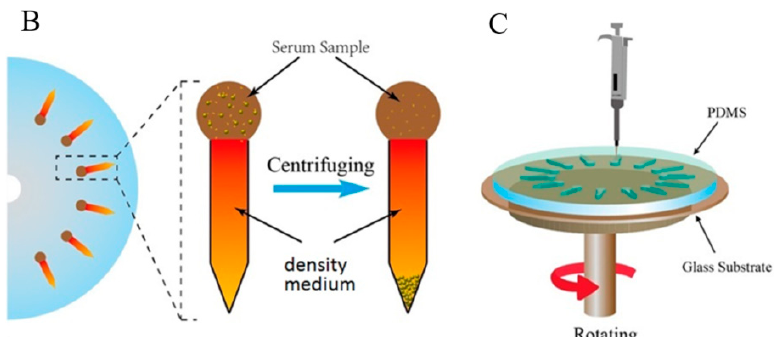
Figure 1. Design of the centrifugal microfluidic device. ( A ) schematic representation of the sandwiched immunocomplex formed by the binding of the target analyte; ( B ) schematic of the centrifugal microfluidic platform immunoassay, depicting the multiplexed analysis of the serum; ( C ) operating principle of the centrifugal microfluidic device.